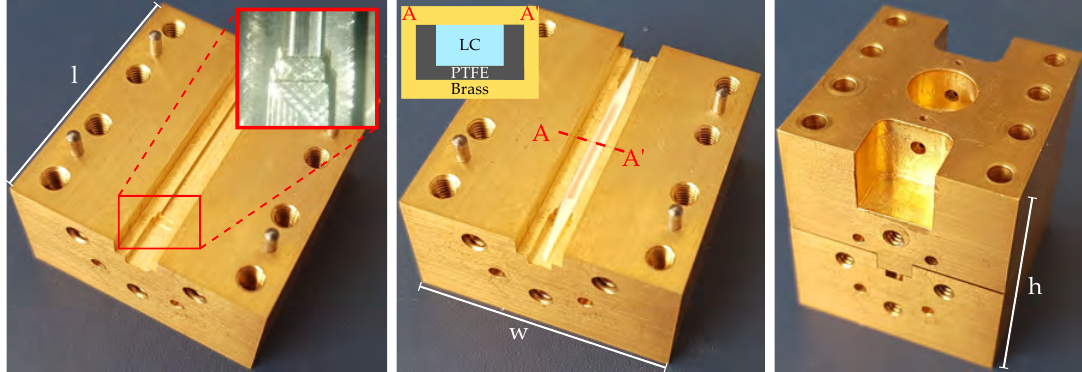
Figure 15. Split-block design of the magnetically biased W-band rectangular waveguide phase shifter based on LC. The dimensions of the split-block are ( l Such phase shifters are used in lightweight horn antenna arrays for satellite communications. 199